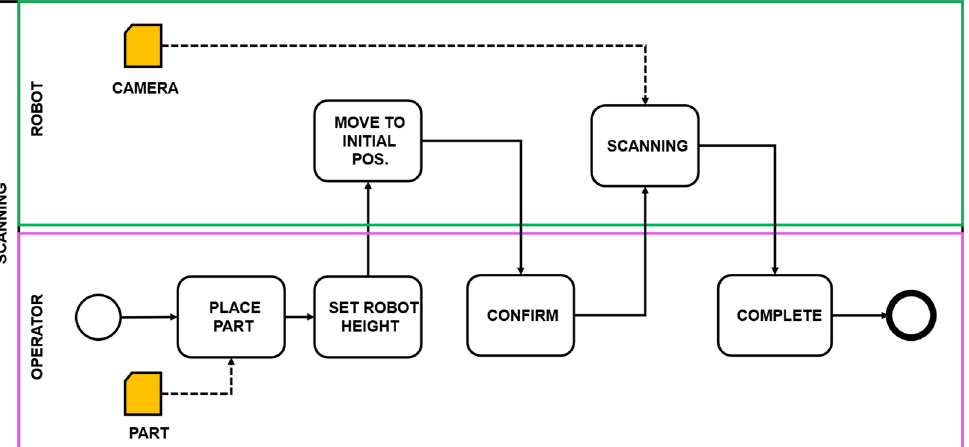
Figure 7. Flow of the envisioned interaction. The human needs to act as the supervisor of the robot and acknowledge when the robot can move on to the next task. All the operator actions are depicted in the operator lane, all the robot actions are depicted in the robot lane.